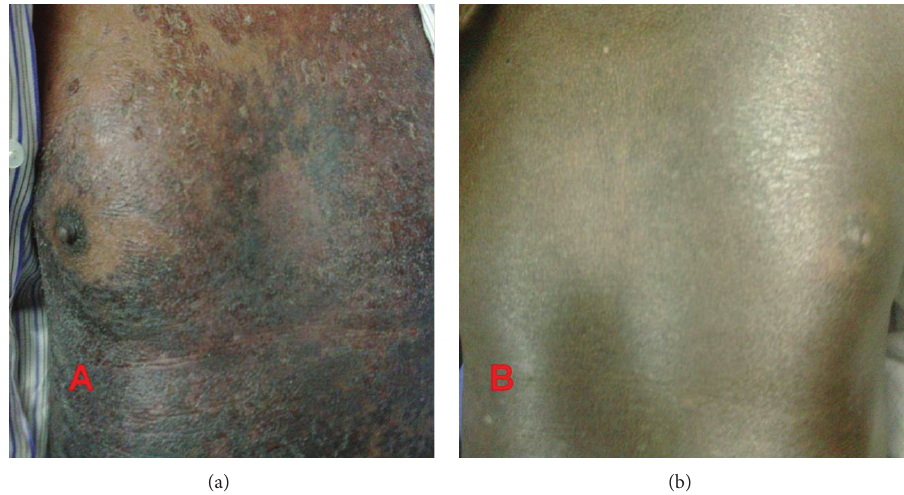
Figure 1: (a) Extensive exfoliation and hyperpigmentation on trunk after starting pyrazinamide. (b) Resolution of exfoliative lesions with residual hyperpigmentation 6 weeks after stopping